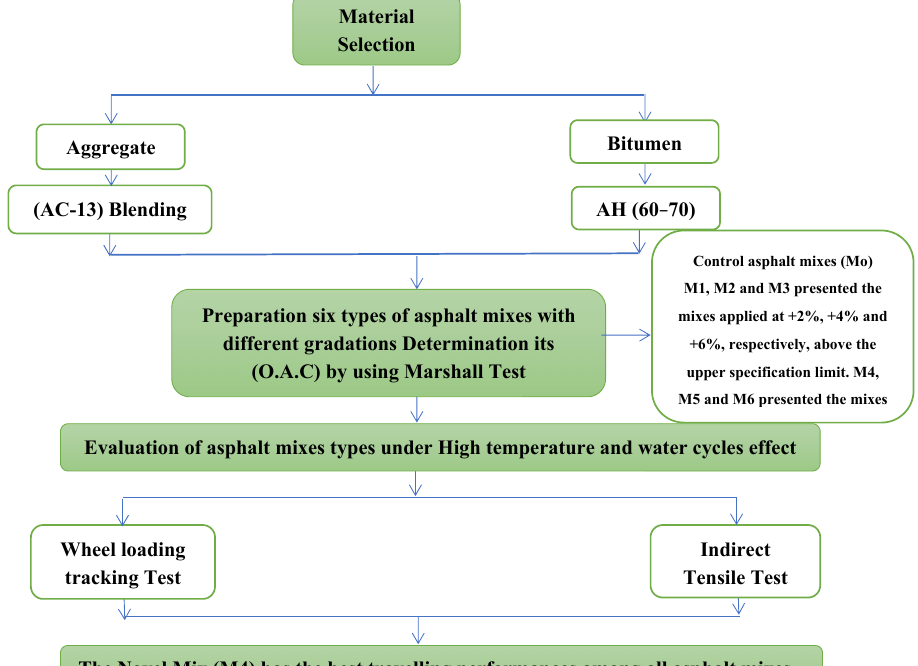
Figure 1. Flow chart of experimental works.